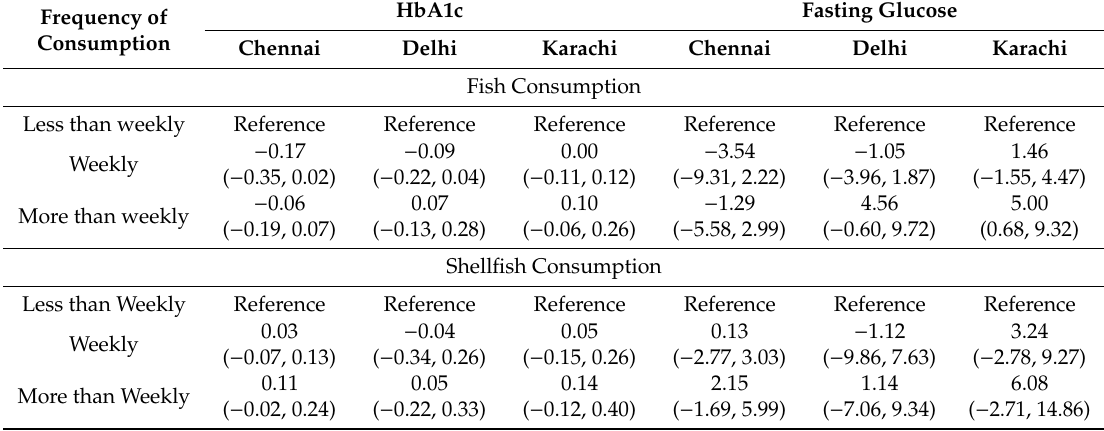
Table 4. Adjusted di ff erences in mean HbA1c and fasting glucose (with 95% confidence intervals) according to fish or shellfish consumption, by city. Note: shellfish consumption is infrequent in Delhi and Karachi. Here, the category “less than weekly” indicates the food item is consumed monthly or never. Adjusted models controlled for age, age 2 , gender, body mass index class, waist–height ratio, sedentary lifestyle, educational attainment, tobacco use, tertile of unhealthy diet score, income, self-reported physician diagnosis of high blood pressure, and self-reported physician diagnosis of high cholesterol. Population parameter estimates are based on a large survey sample including